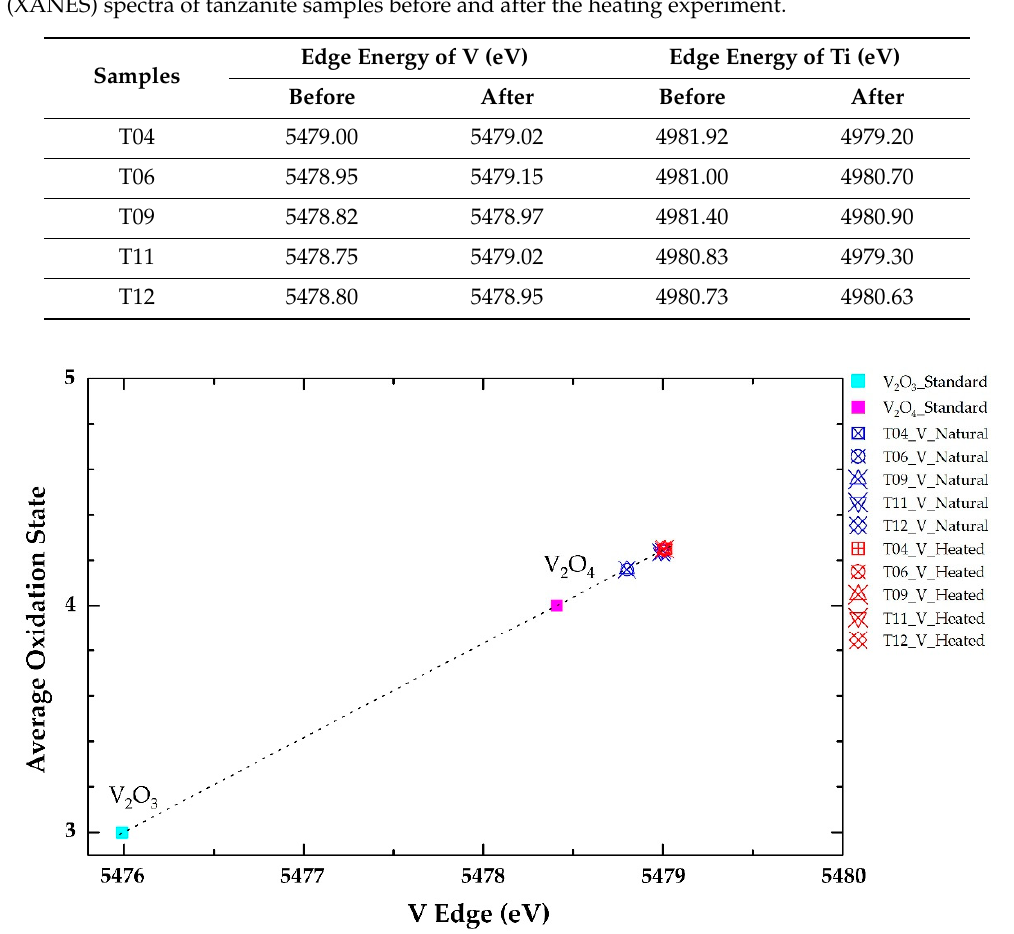
Figure 5. Plots of absorption edge energy (E0) of vanadium in natural tanzanite samples and after heating experiment with a calibration curve (dotted line) fitted by standard V 2 O 3 and V 2 O 4 ; oxidation states of vanadium in most samples appear to increase after heating.